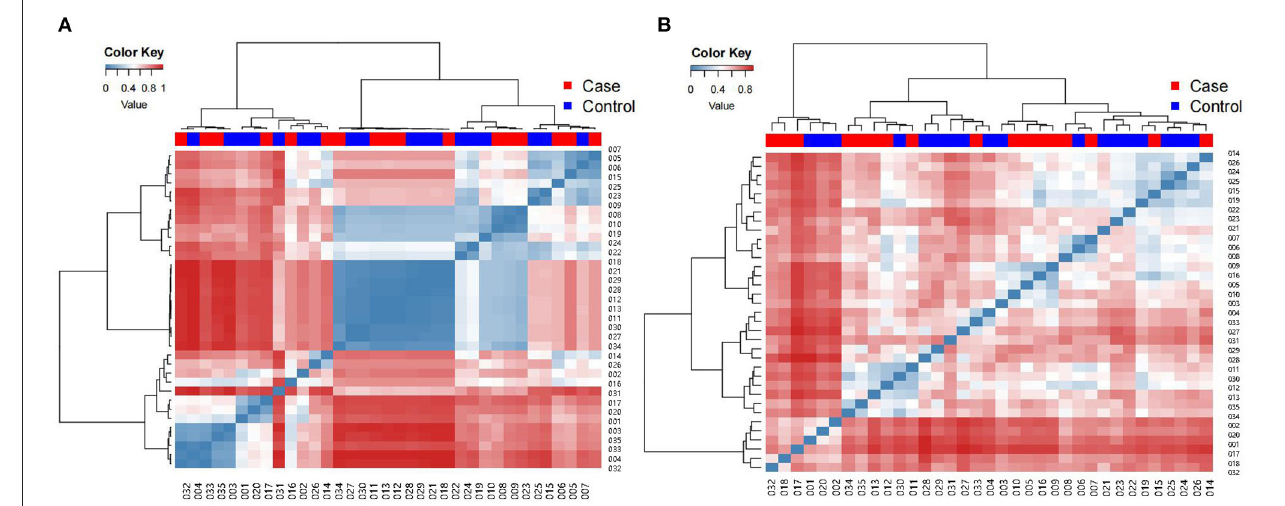
FIGURE 6 | Beta diversity heat map (A) is weighted, (B) is unweighted.